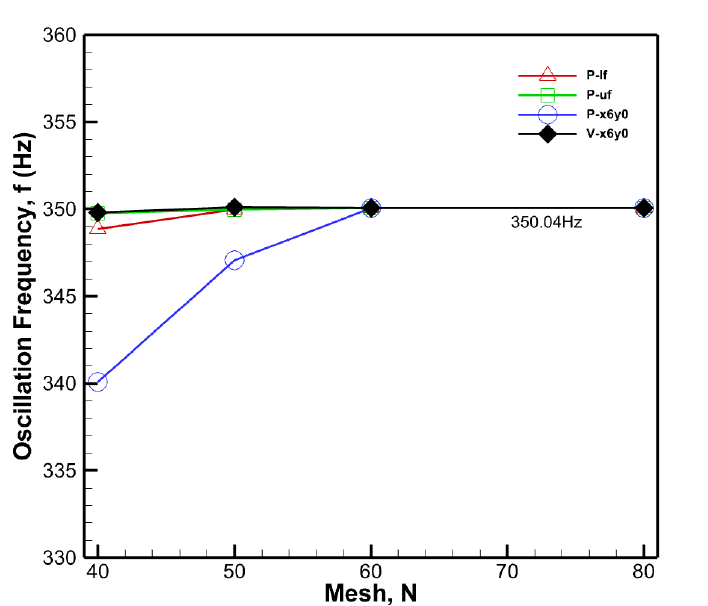
Figure 5. Oscillation frequency obtained from FFT analysis for 0.1s at different sampling points based on the velocity magnitude (v) and static pressure (p): downstream, x6y0 (6 mm, 0 mm), upper feedback channel, uf ( − 25.4 mm, 19 mm), and lower feedback channel, lf ( − 25.4 mm, − 19 mm), for different mesh